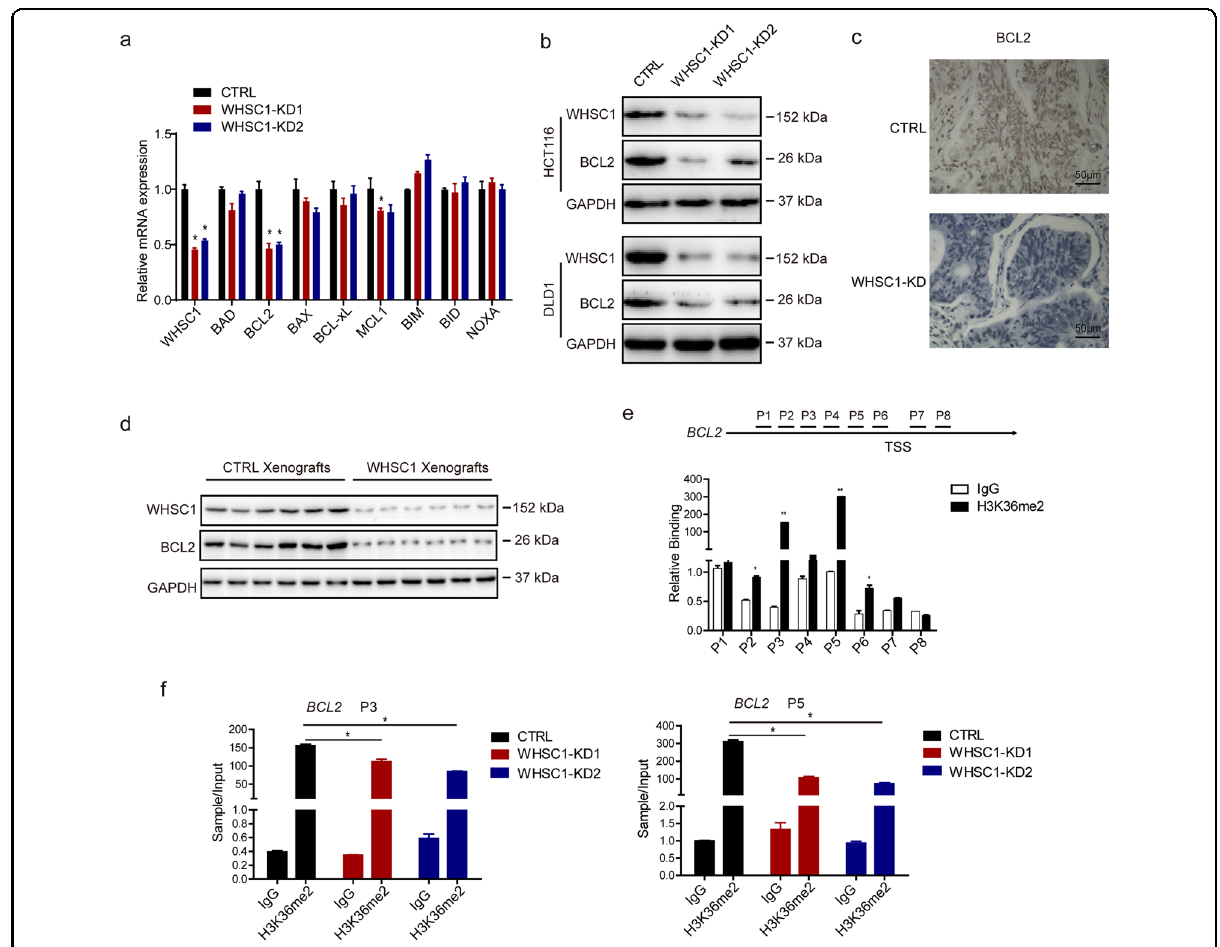
Fig. 5 WHSC1 promotes BCL2 transcription through upregulating H3K36me2 modi fi cation on the gene loci. a , b The mRNA expression of BCL2 family genes in the WHSC1-knockdown HCT116 cells compared with control cells. b The BCL2 protein level in the WHSC1 knock down Hct116 and DLD1 cells compared with control cells. c , d Immunohistochemical and Western detection of BCL2 expression WHSC1 knock down xenografted tumor tissue compared with control tissue. e ChIP-qPCR analysis of the binding of H3K36me2 to the BCL2 promoter in HCT116 cells. f ChIP-qPCR analysis for anti-H3K36me2 along with control IgG at the BCL2 promoter loci in control or WHSC1 knock down HCT116